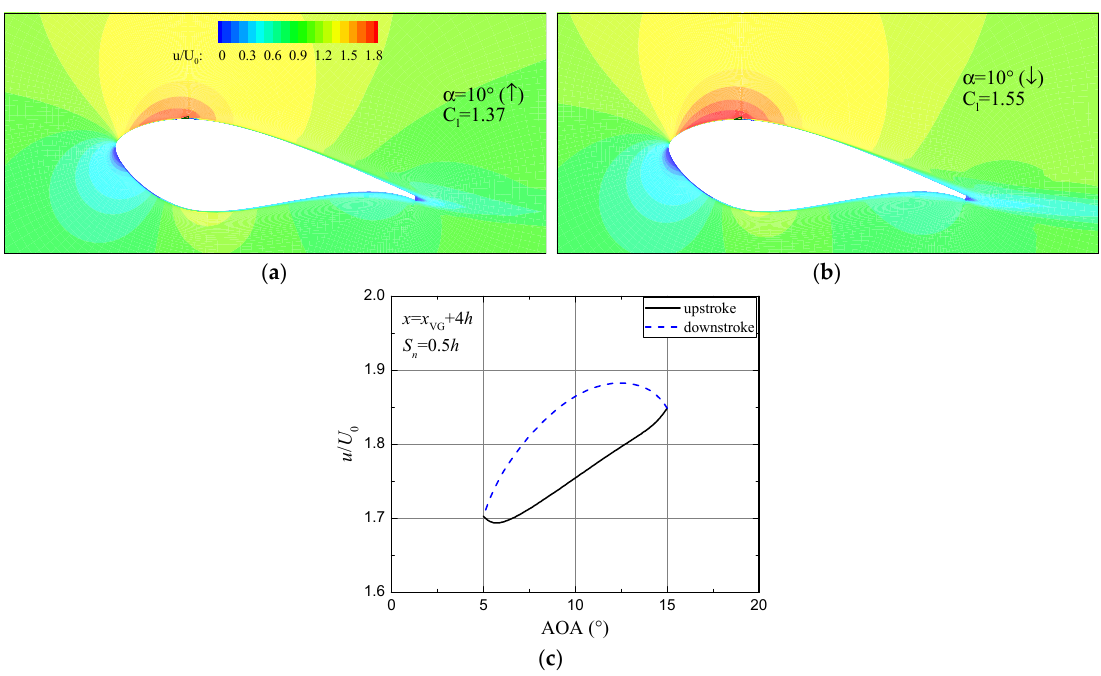
Figure 12. Streamwise velocity profiles of the uncontrolled and controlled airfoil flow at different chordwise locations at α mean = 10 ° . ( a ) without VGs; ( b ) with VGs.